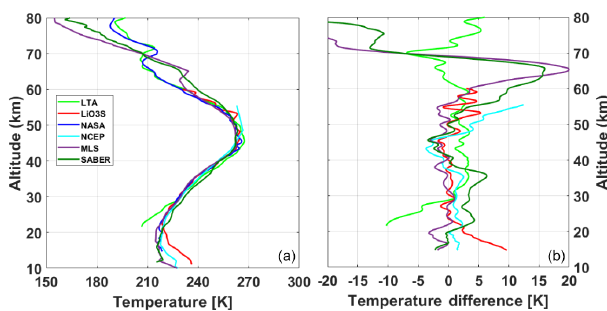
Figure 5. Satellite, NCEP, and lidar temperature profiles measured on the night of 24–25 July 2017 at or near Observatoire de Haute- Provence (a) and temperature difference profiles with respect to the NASA temperature profile (b) . All profiles have been converted to the same 300m vertical spacing altitude grid. For MLS and SABER, the weighted average profile is calculated based on the distance in time and space between the individual satellite profiles and the OHP